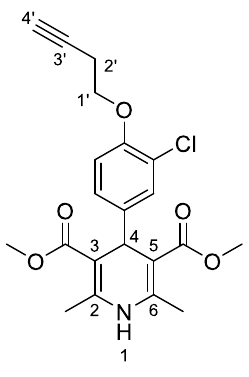
Figure 18. Chemical stucture of 3q .